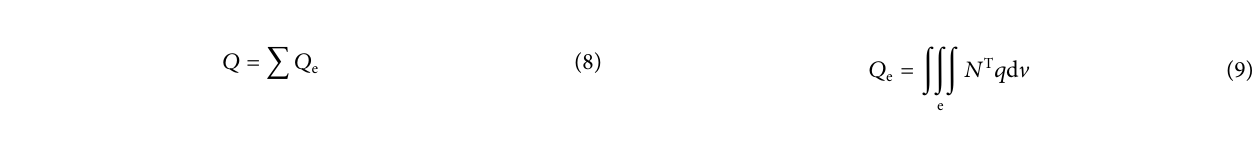
Frontiers in Earth Science |